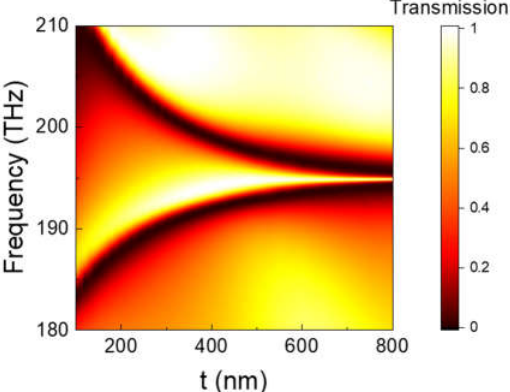
Figure 5. Map of transmission spectra for R-DMS by sweeping coupling distance t from 100 to 800 nm, when l 1 = 900 nm, w 1 = 335